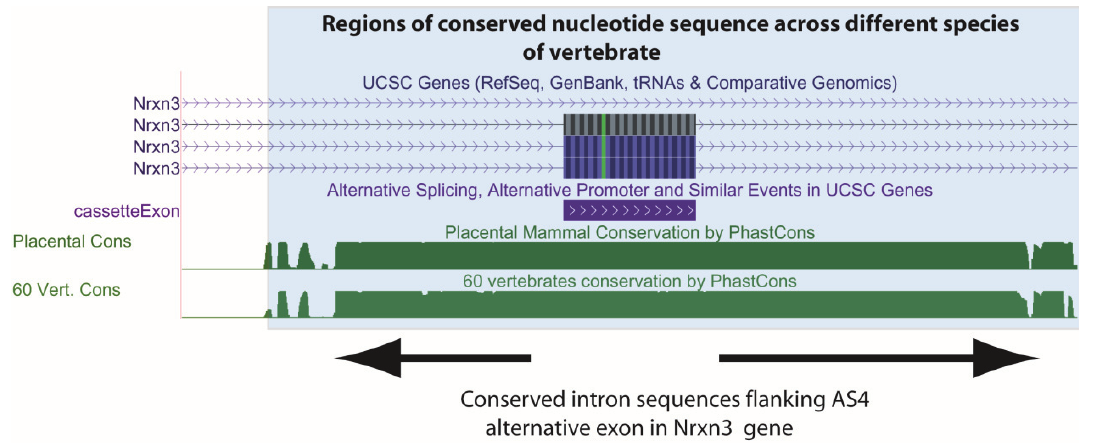
Figure 4. A functional requirement to maintain splicing control sequences constrains evolution of the genome. This screenshot is downloaded from the UCSC genome browser [6] and shows conserved intron sequences flanking the alternatively spliced AS4 exon from the mouse Nrxn3 gene. The conserved sequences are shaded. At the top, the UCSC gene annotations show that this cassette exon is included in ¾ mRNA isoforms made from this gene. At the bottom the Phastcons plot shows that the flanking intron sequences are also highly conserved as well as the exon sequence (exons might be conserved because of their protein-coding content). Conservation of these intron sequences are likely important to control tissue-specific splicing of this exon by the spliceosome. Known alternative events are annotated on the UCSC track “ Alt events ”, and can be shown alongside the gene structure (here the cassette exon is annotated in the alt events track, and is in